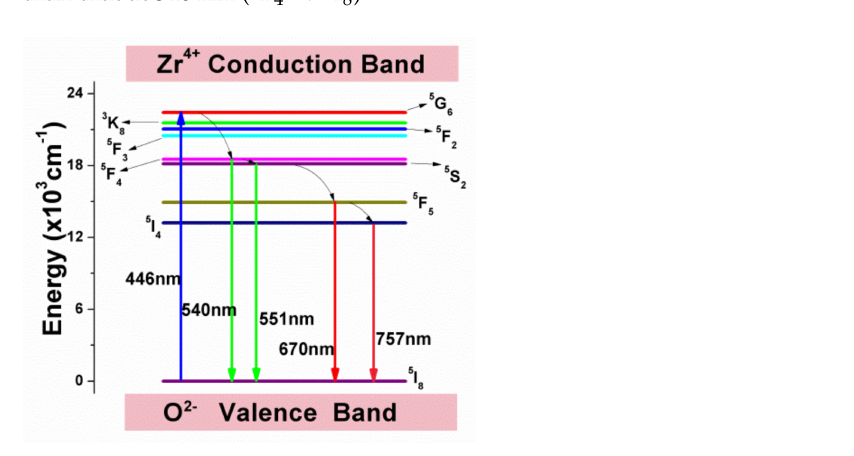
Figure 11. The energy diagram of Ho 3+ in Ho 2 O 3 doped YSZ crystals with the radiative and non- radiative